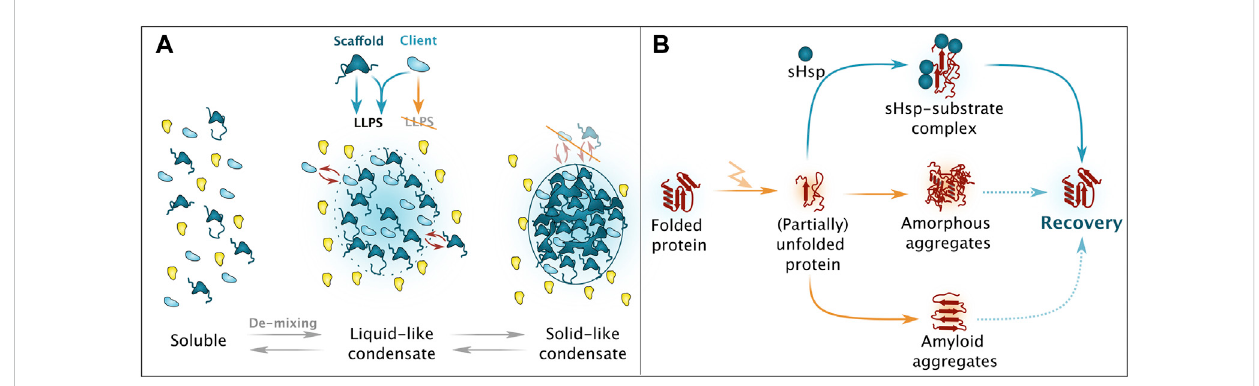
FIGURE 2 Simpli fi ed overview on phase separation and aggregation. (A) Upon presence of scaffold proteins with potent liquid-liquid phase separation (LLPS)- enablingfeatures, de-mixingofaproteinsolutioncantakeplace,eventuation inliquid-likecondensates,consistingofbothscaffold (darkblue)andclient (light blue) proteins. Ageing processes result in solid-like condensates that no longer support dynamic exchange of constituents with the surrounding milieu. Please note that also chaperones and protein quality control factors are involved in these processes. (B) Unfolded resp. partially unfolded protein species can adopt different aggregate forms. Depending on the intrinsic nature, amorphous as well as amyloid aggregates can occur, with a limited potential for recovery. Small heats hock proteins (sHsps) are responsible for targeted and regulated sequestration and alleviate subsequent